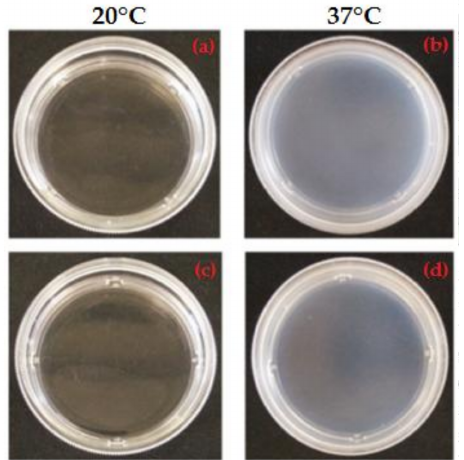
Figure 2. Sol-gel transition of the MC-based hydrogels tested: sol, hydrophilic state at 20 ◦ C (T < LCST): ( a ) MC-Na005, ( c ) MC-PBS20; gel, hydrophobic state at 37 ◦ C (T > LCST): ( b ) MC-Na005, ( d )